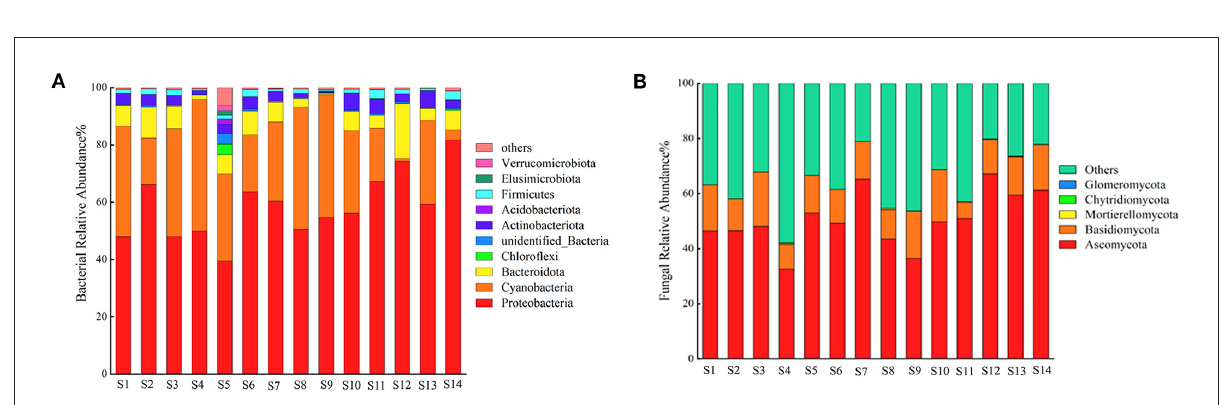
FIGURE2 The relative abundance of the top 10 phyla of bacteria in seed lot from 14 ecotypes 16s ribosomal RNA sequencing (A) and fungi in seed lot from 14 ecotypes ITS sequencing (B)